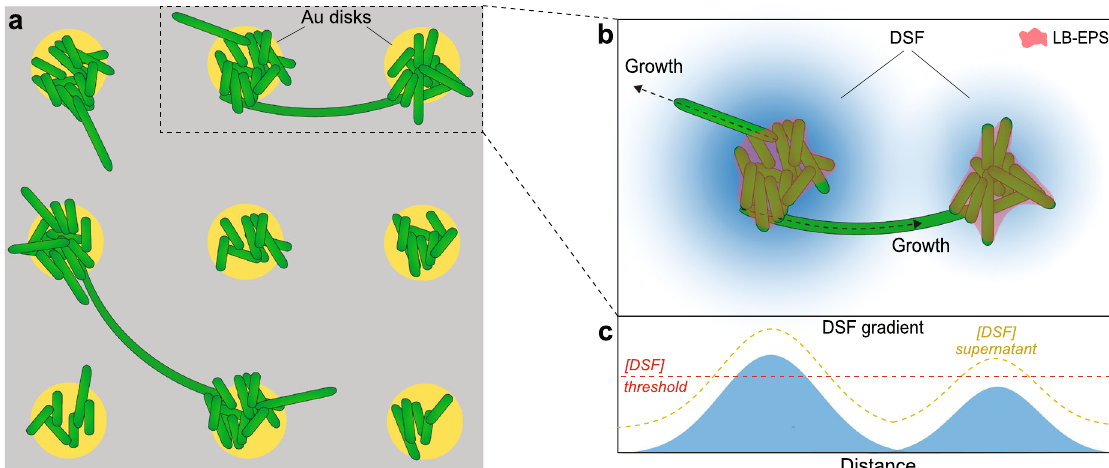
Fig. 6 Proposed model of DSF-regulated fi lamentous cell formation and cluster interconnection. a Schematic representation of experimentally observed fi lamentous cells interconnecting adjacent cell clusters. b , c High, cluster density-dependent local DSF concentration (in blue) above a certain DSF concentration threshold ( c , dashed red line) triggers fi lamentous cell growth of non- or partly-EPS covered cells localized at cluster boundaries. The addition of supernatant extract abundant with diverse DSF increases the global DSF concentration ( c , dashed yellow line) resulting in fi lamentous cell formation also at clusters with prior insuf fi cient DSF concentration (see also Fig. 5), such as those separated by 14 μ m distance (Fig.